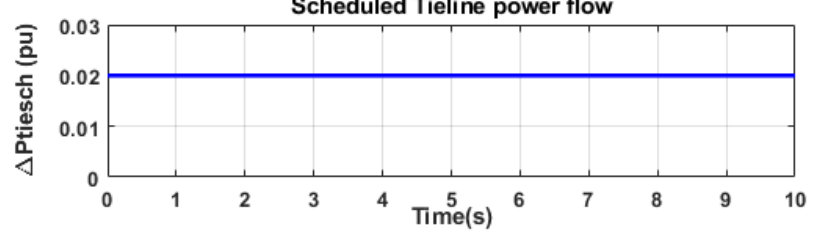
Figure 16. Tie line power flow in bilateral